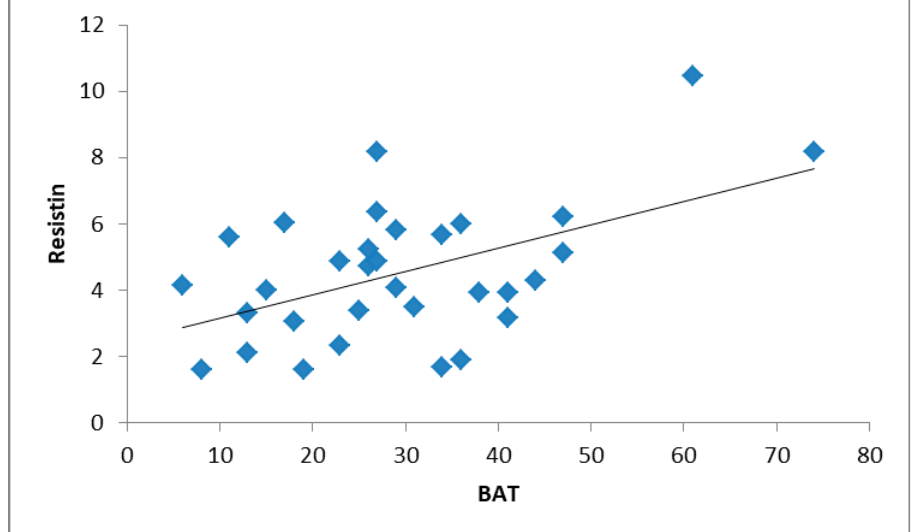
Figure 1. Correlation between resistin and BAT in RGs (r = 0.35; p = 0.047).